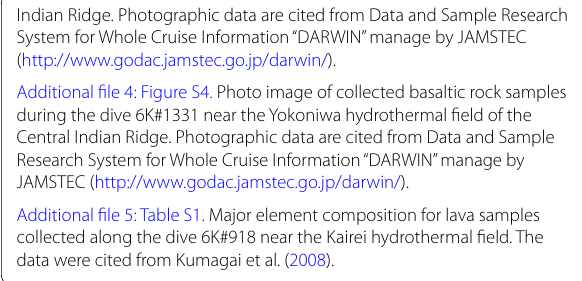
Addit ional file 4: Figur e S4. Photo image of collected basaltic rock samples during the dive 6K#1331 near the Yokoniwa hydrothermal field of the Central Indian Ridge. Photographic data are cited from Data and Sample Research System for Whole Cruise Information “DARWIN” manage by JAMSTEC (http://www.godac .jamst ec.go.jp/darwi n/). Addit ional file 5: Table S1. Major element composition for lava samples collected along the dive 6K#918 near the Kairei hydrothermal field. The data were cited from Kumagai et al.